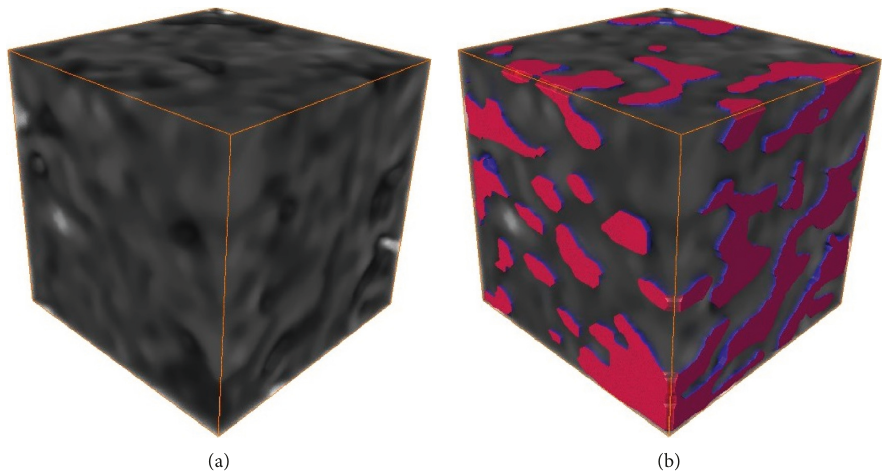
1 . (a) Coal sample. (b) Pores and skeletons. (c) Pores (with an absolute porosity of